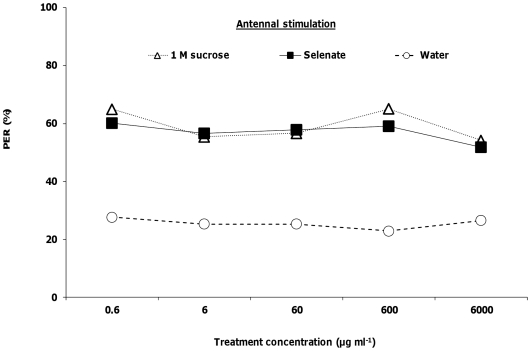
Honey bee behavioral responses to antennal stimulation with selenate.Honey bees were stimulated with 1 M sucrose, water, and selenate in 1 M sucrose (N = 83). Asterisks indicate significance of *P<0.05, **P<0.001, ***P<0.0001 (Logistic regression with multiple comparisons) between 1 M sucrose and treatment lines.